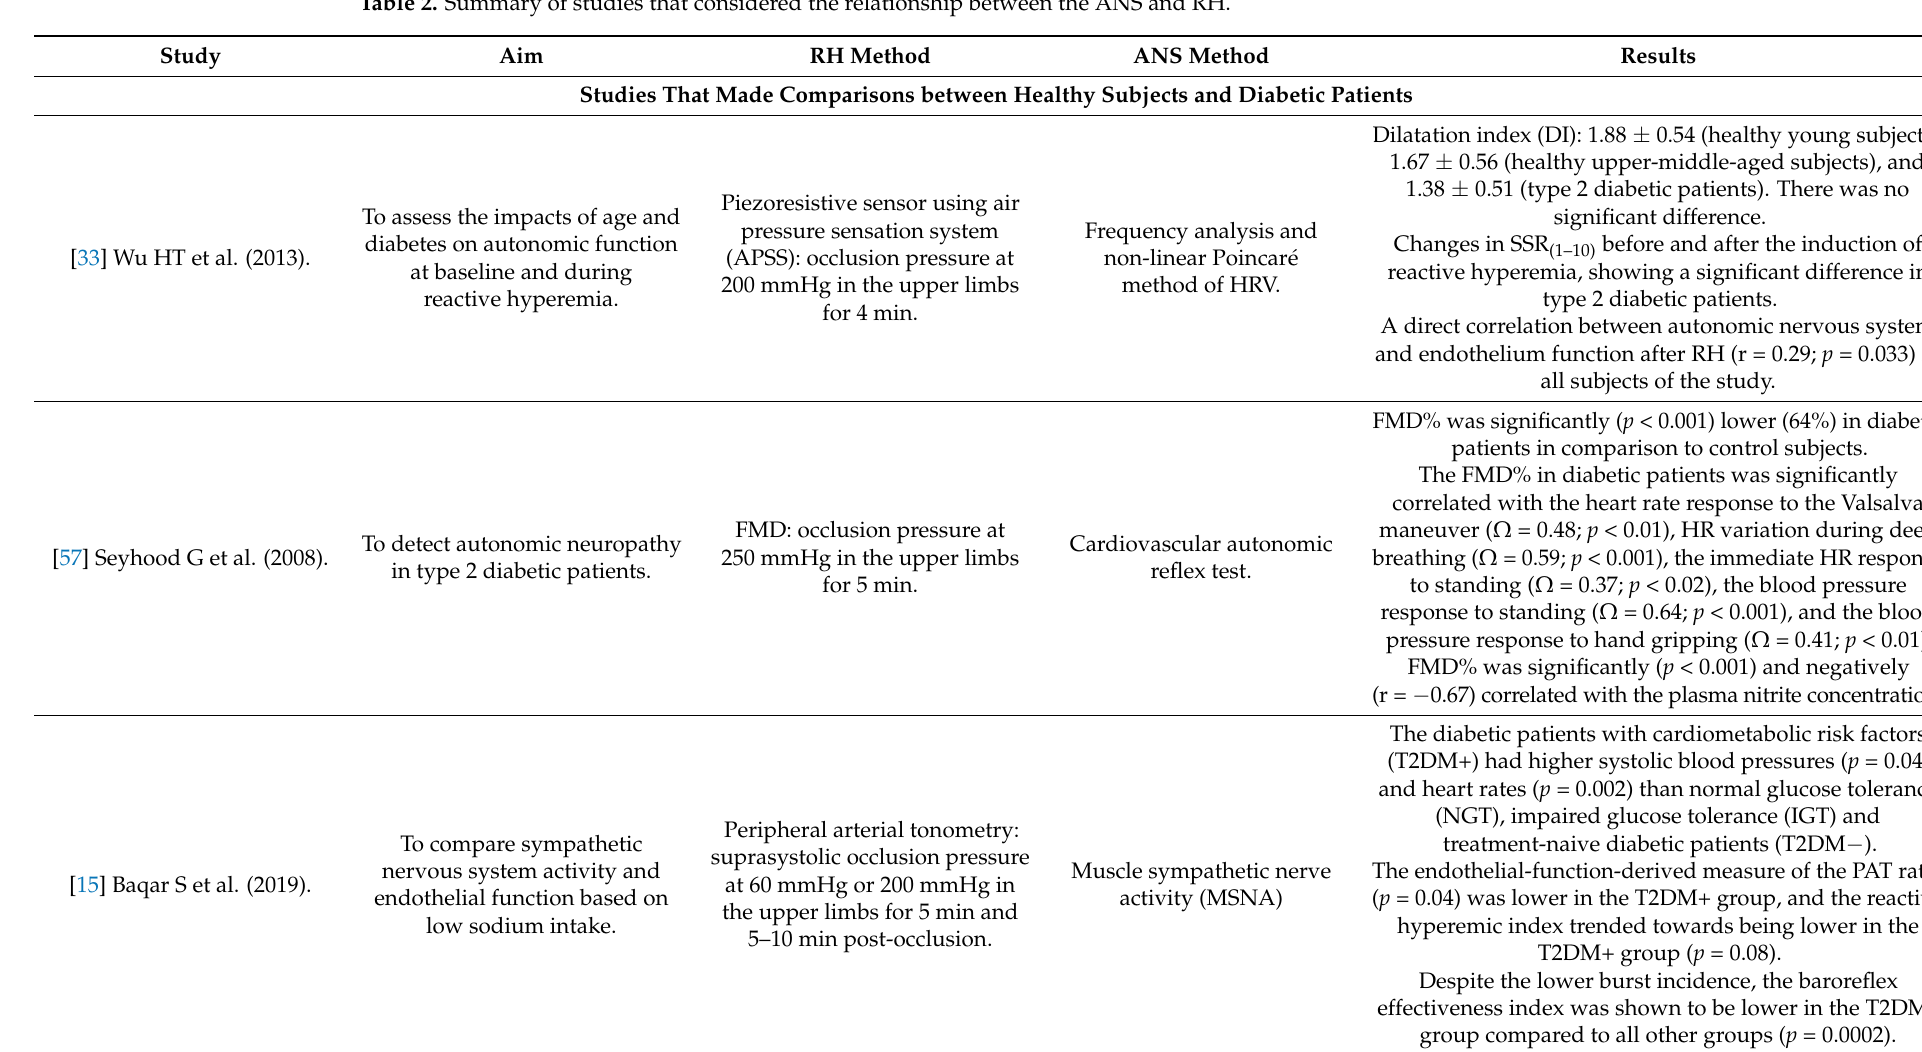
Table 2. Summary of studies that considered the relationship between the ANS and